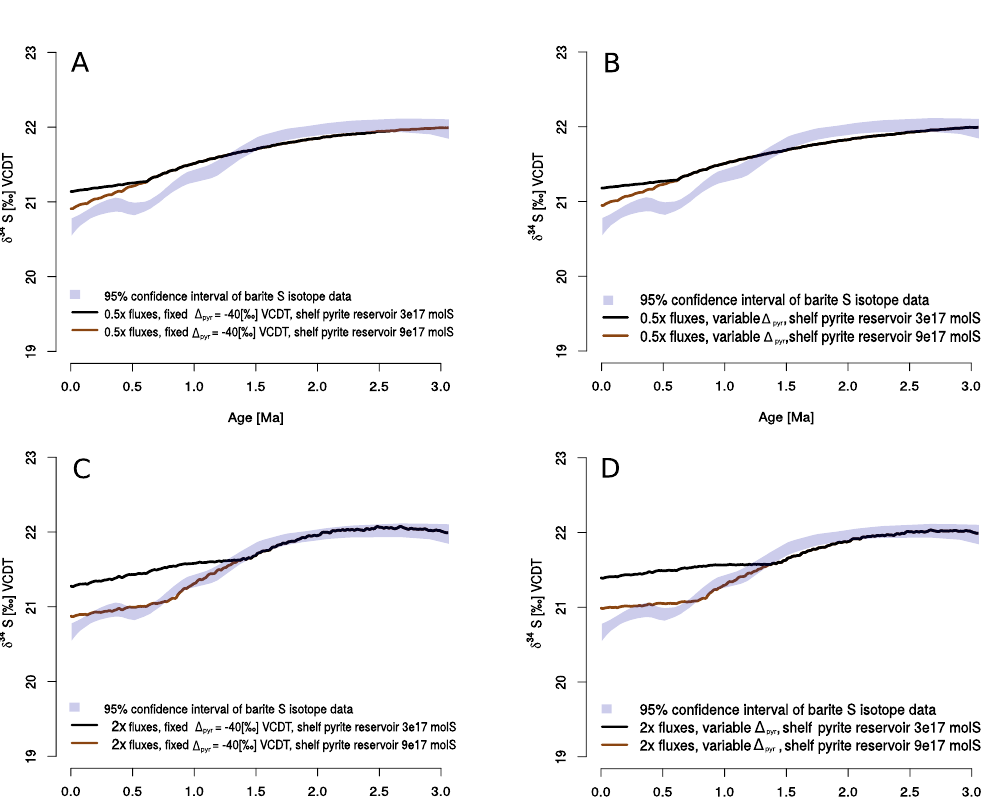
Figure A3. Sensitivity model tests. (a) Model output using fixed (cid:49) pyr and assuming initial fluxes at 50% steady state values. (b) Model output using variable (cid:49) pyr and assuming initial fluxes at 50% steady state values. (c) Model output using fixed (cid:49) pyr and assuming initial fluxes at 200% steady state values. (d) Model output using variable (cid:49) pyr and assuming initial fluxes at 200% steady state values. Note: black solid line – model outputs produced assuming the low estimate for shelf pyrite sub-reservoir. Brown solid line – model outputs produced assuming the high estimate for shelf pyrite sub-reservoir. The shaded area represents the 95% confidence interval of a LOESS approximation of the “true” δ 34 S SO value (for forcing see Figs. 4